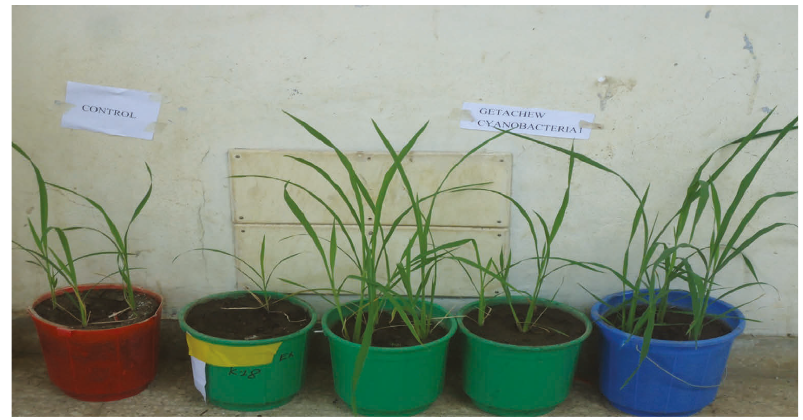
Figure 1: Growth of rice seedlings on the pot